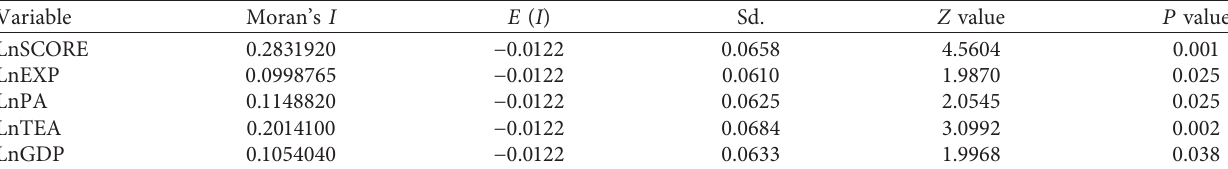
Table 1: Results of the global spatial autocorrelation test.